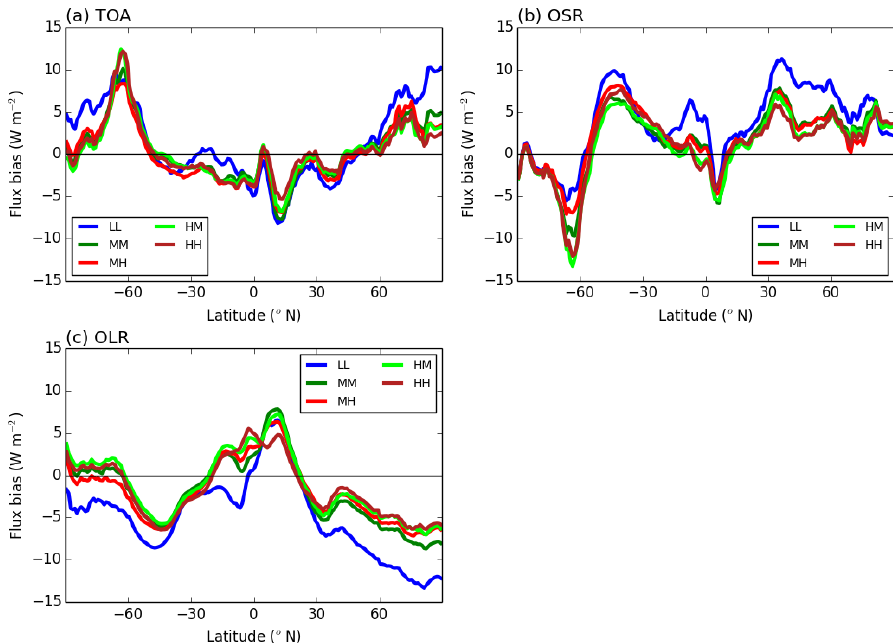
Figure 3. Annual mean zonal mean model radiation biases (years 50–100) of top-of-atmosphere radiation components against CERES- EBAF observations for 2000–2018 (Kato et al., 2013). (a) Top-of-atmosphere net radiation; (b) outgoing shortwave radiation; (c) outgoing longwave